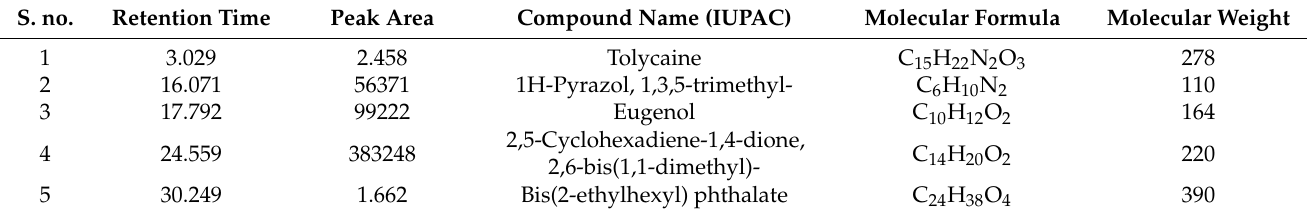
Table 4. GC-MS analysis of P. neglecta endophytic EtOAc extract. The possible existence of bioactive compounds and its retention time, peak area, molecular formula, and molecular weight.